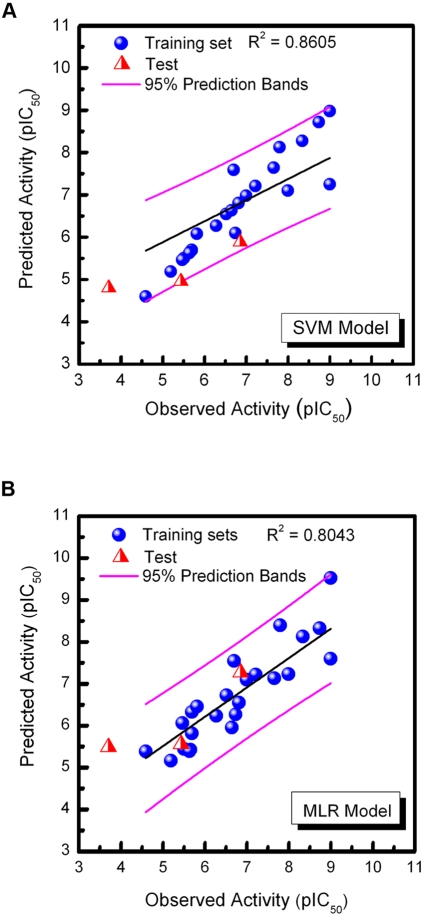
Correlation between observed and predicted activities (pIC50) of 27 neuraminidase inhibitors using different prediction models.(A) MLR and (B) SVM.